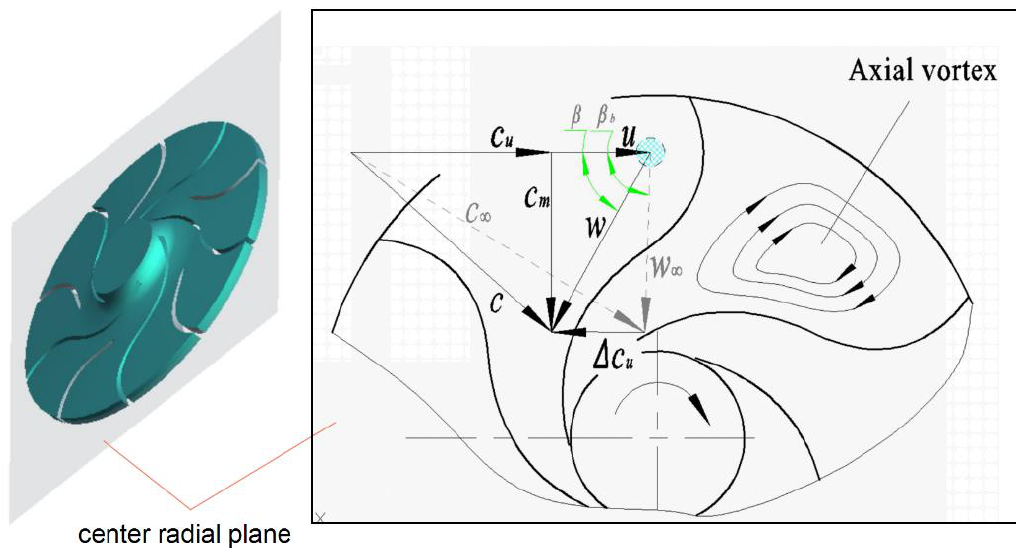
Figure 2. The model of the large axial vortex in PAT.